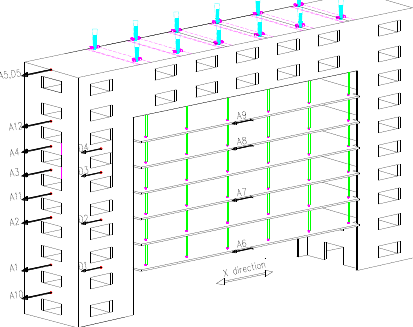
Figure 6. Layout of the displacement and acceleration sensors.